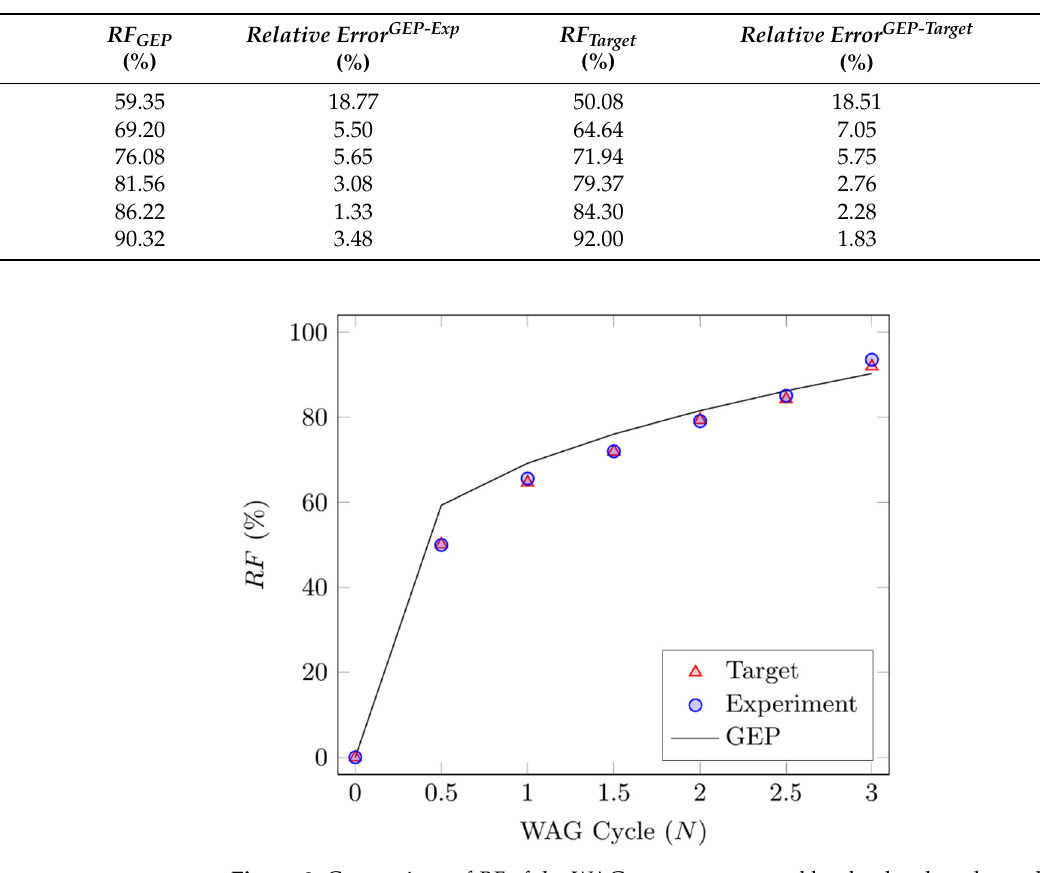
Figure 8. Comparison of RF of the WAG process generated by the developed correlation, mathematical model, and experimental tests.